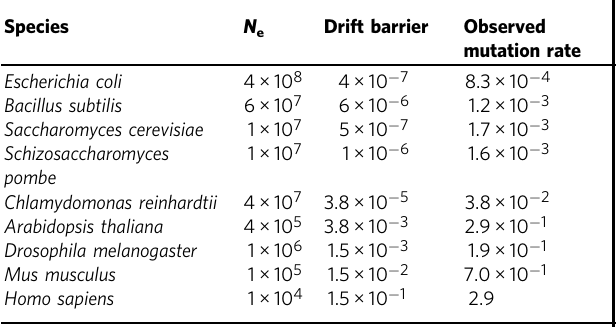
Table 2 Observed SNV mutation rates per functional genome per generation and the corresponding drift barriers of model organisms.